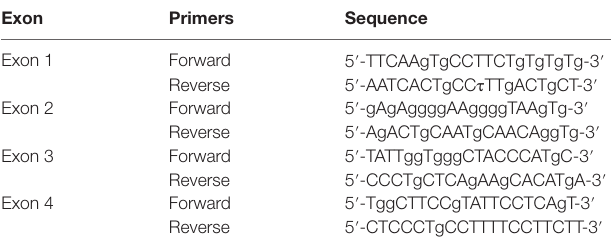
Table 1 | The sequences of primers used for the amplification of CTLA4. exon Primers sequence Exon